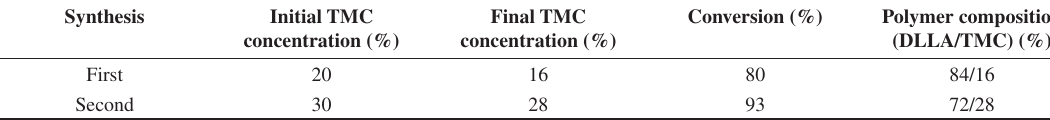
Table 2. TMC concentrations and terpolymer compositions calculated from 1 H-NMR spectra.